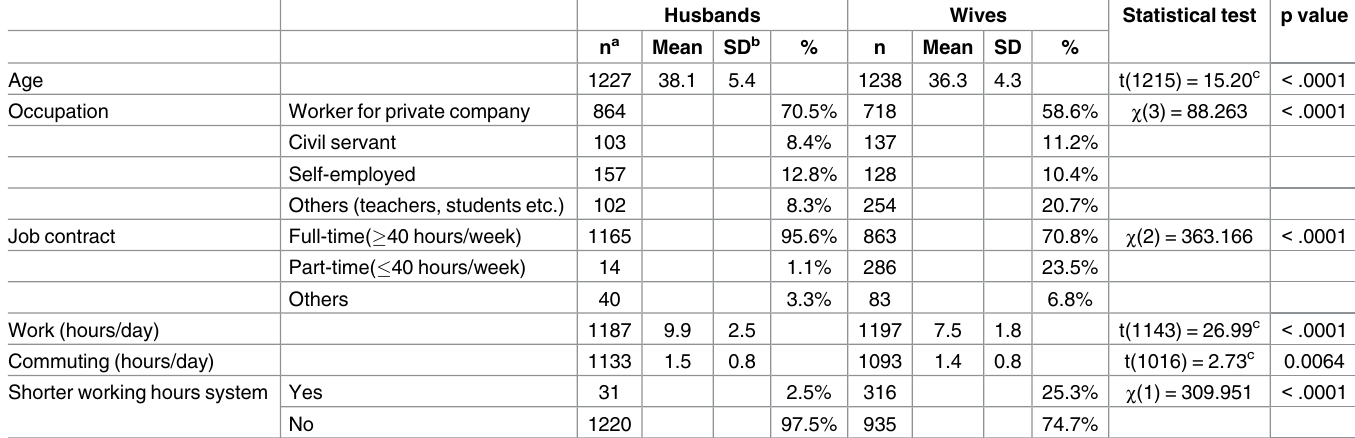
Table 1. Comparison of the demographic characteristics between husbands and wives.